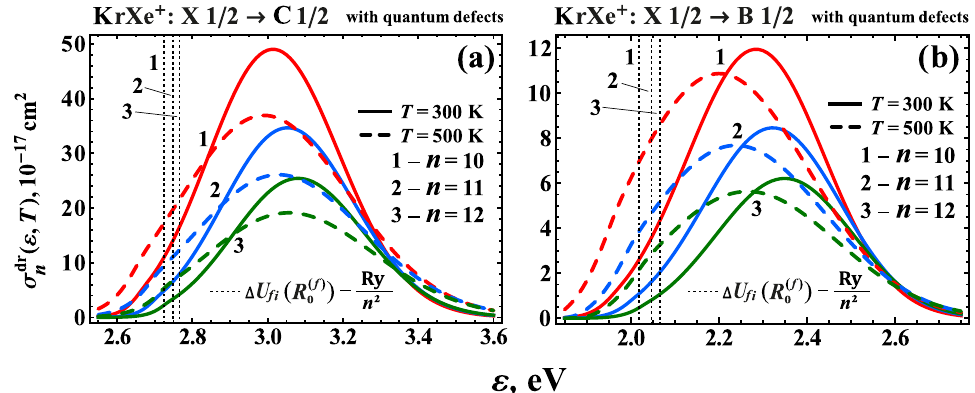
Figure 9. Cross sections of dissociative recombination, σ dr n ( ε , T ) , of KrXe + ions followed by pop- ulation of any nl -sublevel Kr( nl ) of Rydberg states with n = 10, 11, 12, realized via non-adiabatic transitions of A -type, KrXe + ( X 1/2 ) + e → KrXe ( C 1/2, nl ) →→ Xe + Kr ( 2 P 1/2 nl ) ( a ) and B -type KrXe + ( X 1/2 ) + e → KrXe ( B 1/2, nl ) →→ Xe + Kr ( 2 P 3/2 nl ) ( b ) at gas temperatures T = 300